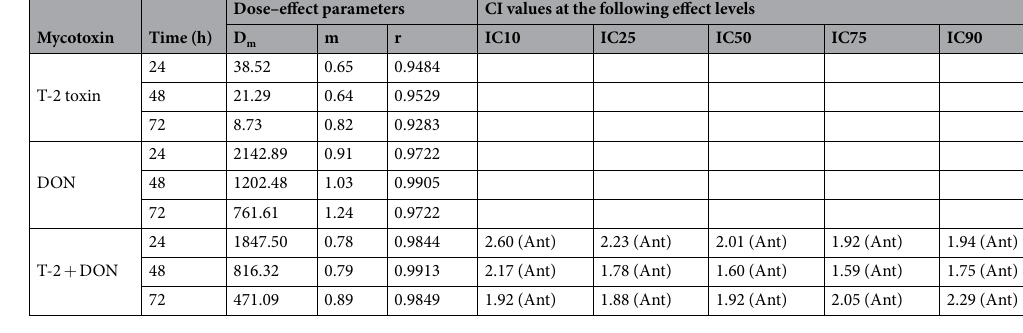
Table 2. Dose–effect relationship parameters and mean combination index (CI) values of T-2 toxin or DON alone or in combination on C28/I2 cells. The parameters m, D m , and r are the slope, antilog of the x-intercept, and the linear correlation coefficient of the median-effect plot, which signifies the shape of the dose-effect curve, the potency (IC50), and the conformity of the data to the mass-action law, respectively. IC10, IC25, IC50, IC75, and IC90 are the doses required to inhibit proliferation by 10%, 25%, 50%, 75% and 90%, respectively. Ant indicates antagonistic effect.